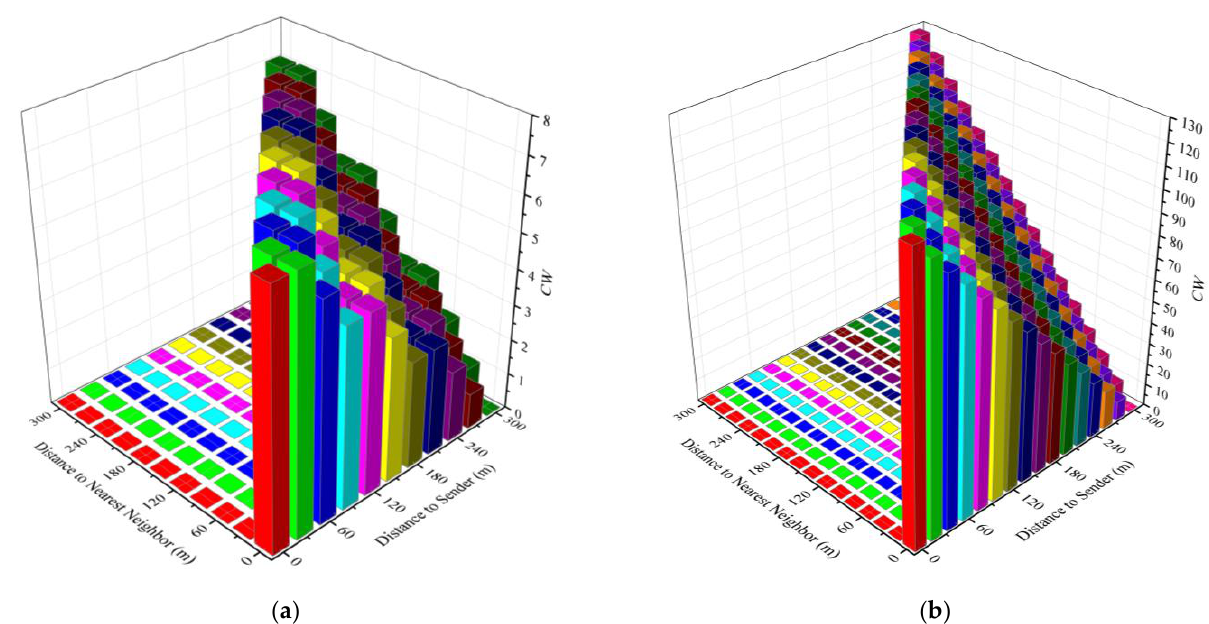
Figure 8. The ForwardCW min and ForwardCW max values when CW = 7 and CW = 128, respectively. ( a ) The ForwardCW min and ForwardCW max values with different d ( x ) and d min ( x ) when CW = 7; ( b ) the ForwardCW min and ForwardCW max values with different d ( x ) and d min ( x ) when CW = 128.